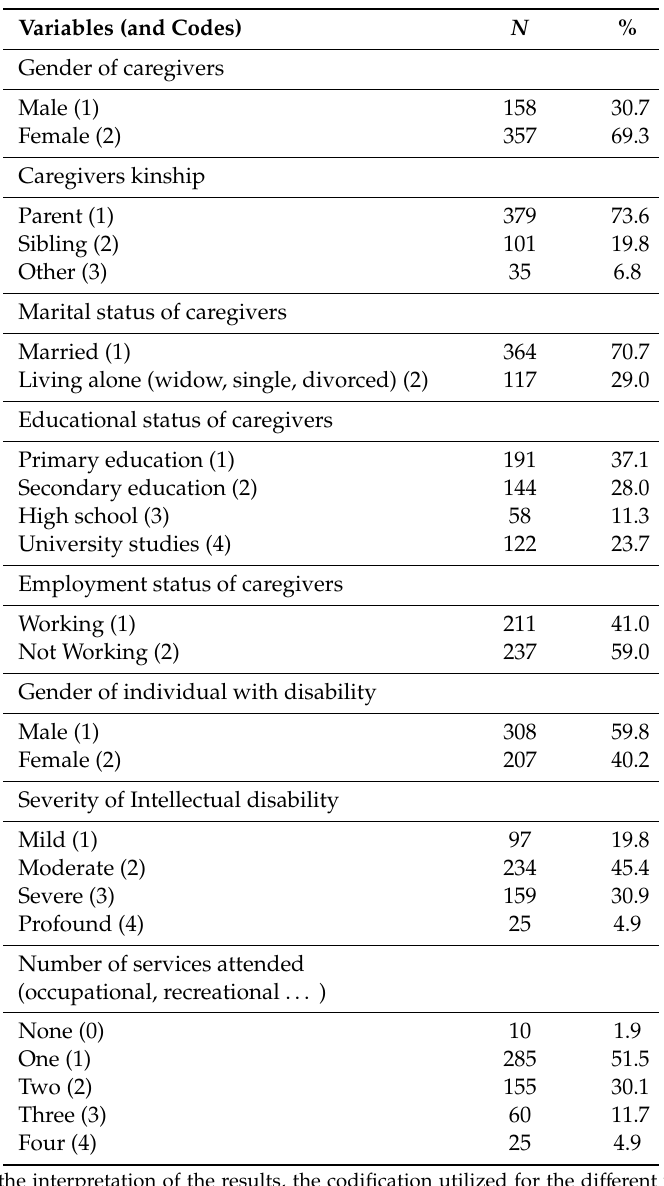
Table 1. Demographics of the informants and individuals with